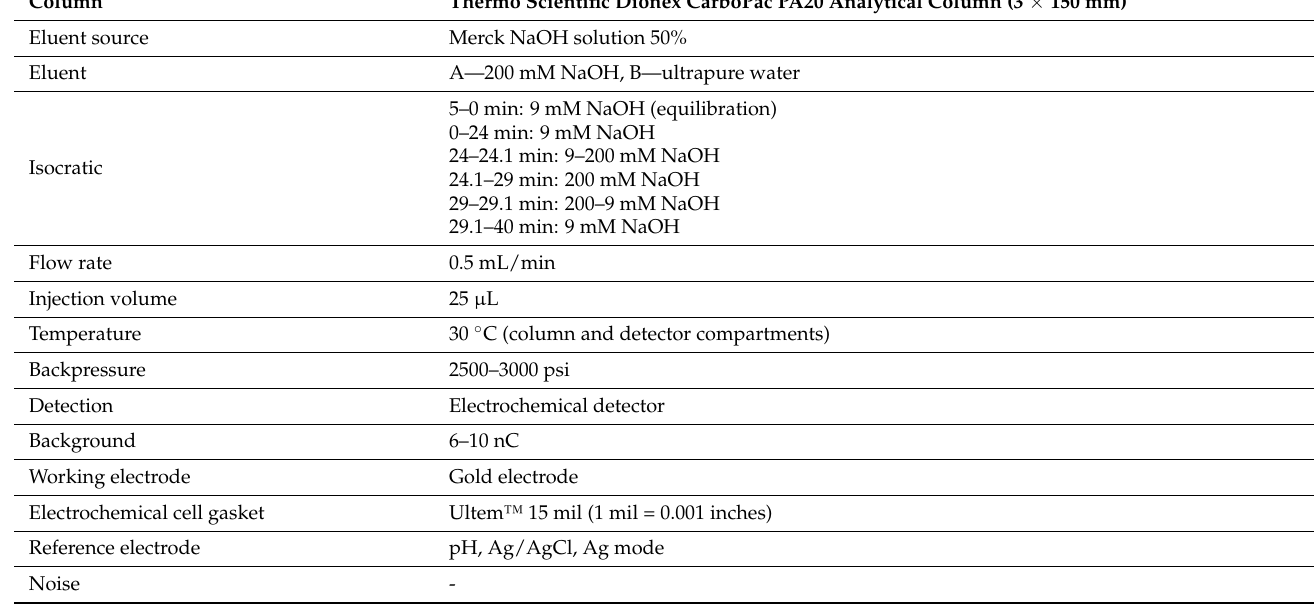
Table 8. Sugar profiling